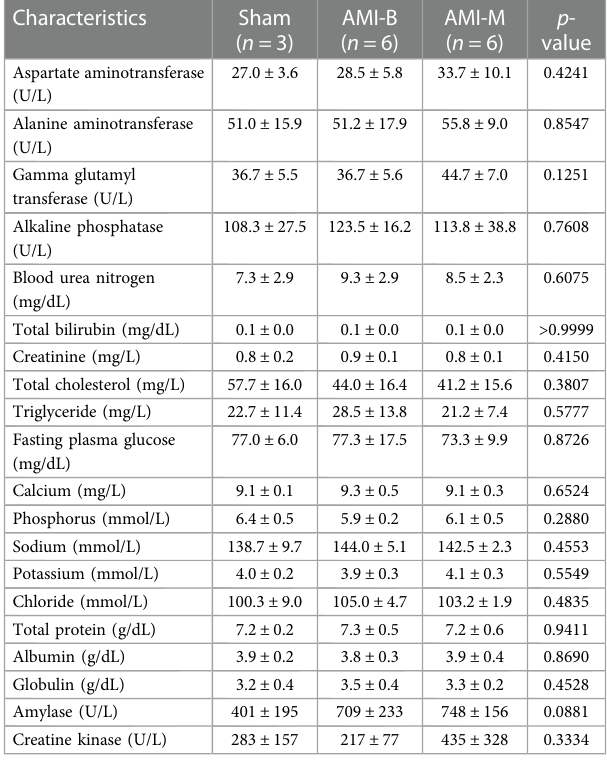
TABLE 3 Biochemistry characteristics of three groups at baseline. Characteristics